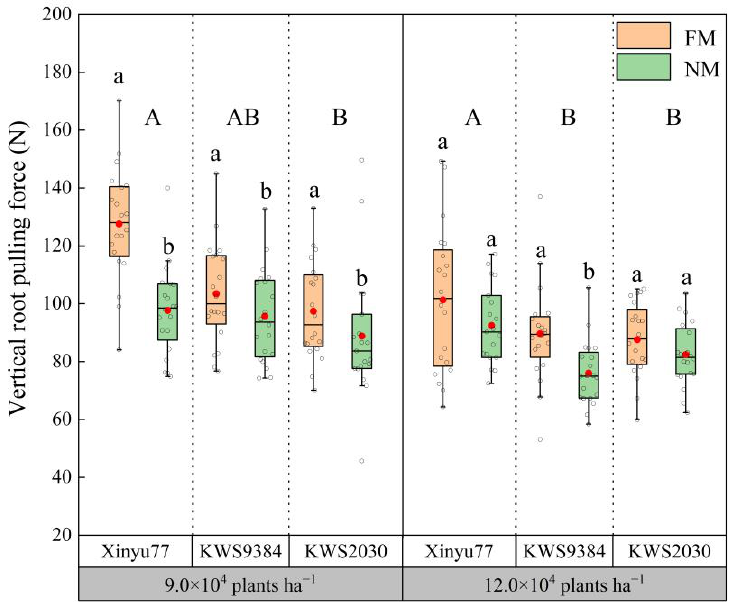
Figure 6. Differences among the vertical root-pulling forces between film mulch (FM) and no-film (NM) planting under different planting densities and cultivars. The boxes represent IQRs, the whiskers indicate the reasonable sample borders (Tukey tests), the horizontal line in each box indicates the median, and the solid red dot shows the mean. Different lowercase letters indicate significant differences ( p < 0.05) between the FM and NM treatments. Different capital letters indicate significant differences ( p < 0.05) among cultivars. Table 2. Differences of maize root morphology between film mulch (FM) and no-film (NM) planting. Plant Density (Plants ha − 1